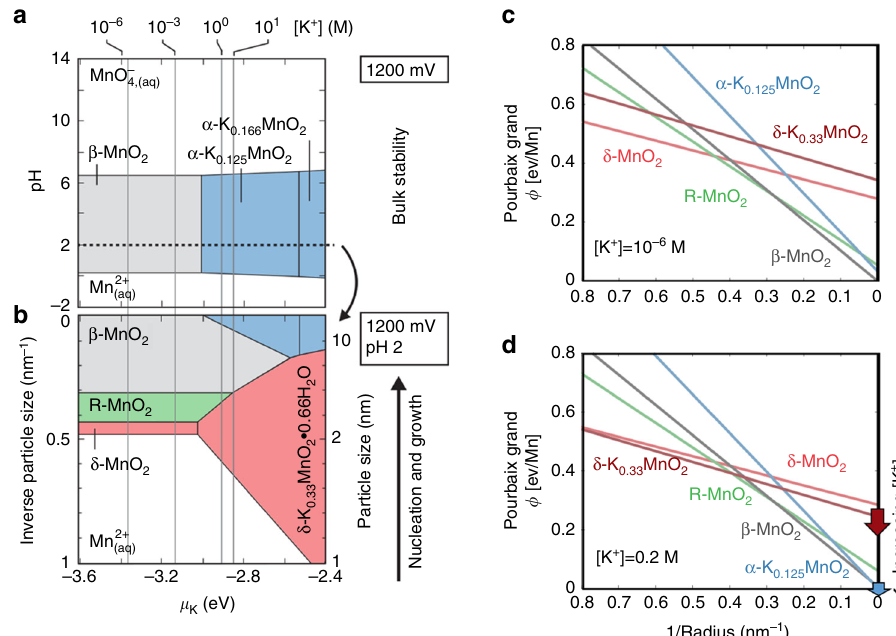
Fig. 2 Phase diagrams of K-Mn oxide systems at E = 1.2 V. a pH- μ K slice at 1/ R = 0 indicating bulk stabilized phases. b 1/ R - μ K slice at pH = 2 illustrating the size-stabilized phases. c , d Pourbaix grand free-energies versus 1/ R , showing the metastable energy landscape of crystal growth where [K + ] = 10 − 6 M ( c ) and [K + ] = 0.2 M ( d ). d is representative of pathways at both [K + ] = 0.2 M and [K + ] = 0.33 M due to their similar [K + ]. The three reaction conditions are referred to as P K = 0 , P K = 0.2 , and P K = 0.33 , respectively, based on their [K + ]. d ð Φ δ (cid:2) for the transformation from the δ to the α phase decreases at a larger [K + ]. The red and blue arrows indicate the trend that the slope of Φ δ (cid:2)